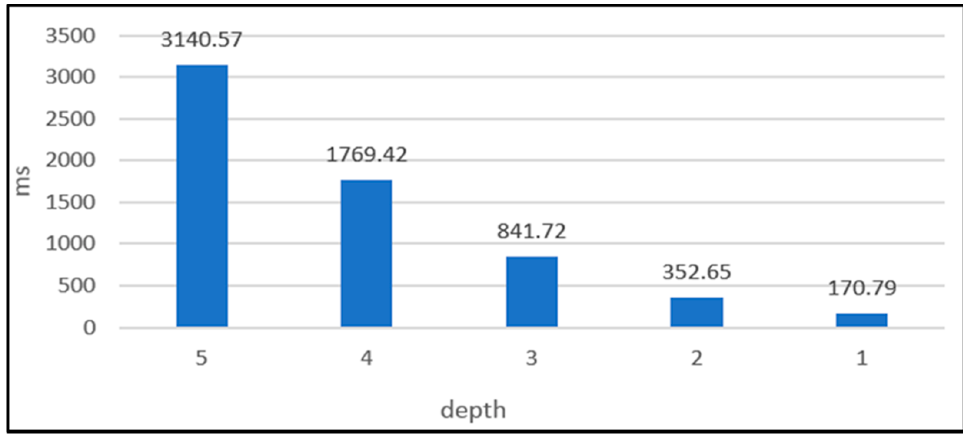
Figure 12. Cost of Tip Select .